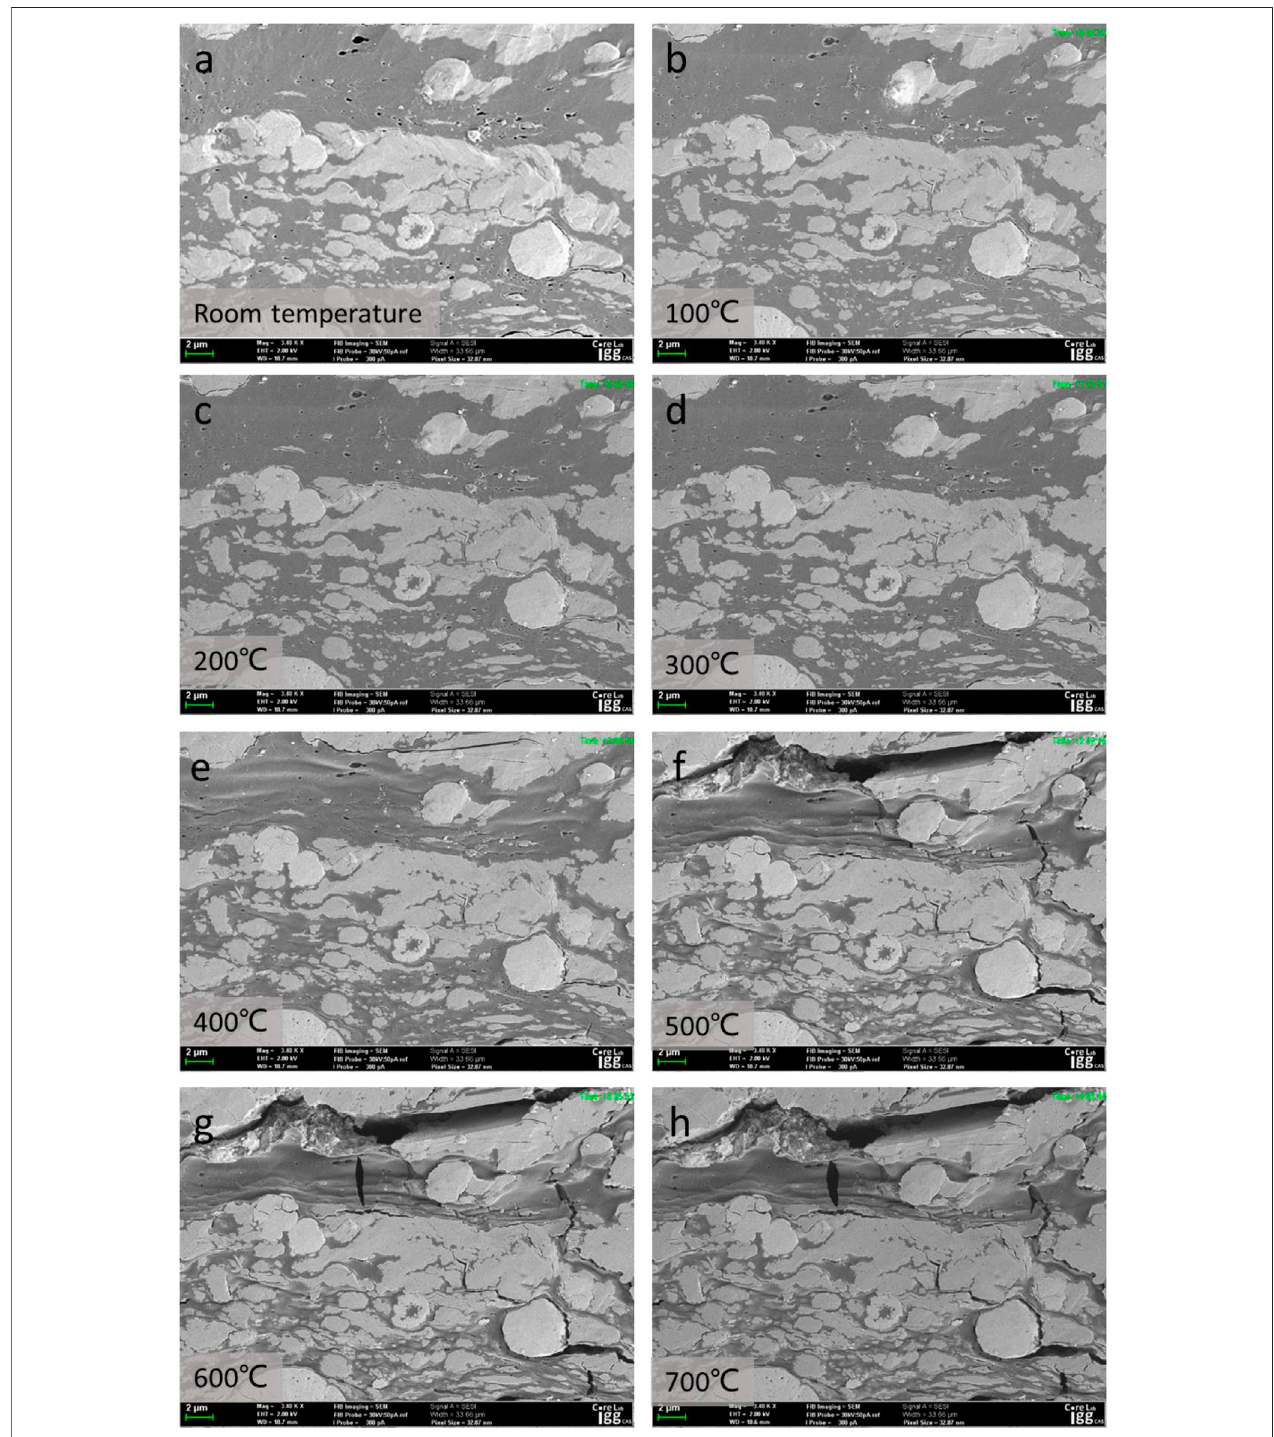
FIGURE 11 | Expansion and opening of cracks during temperature